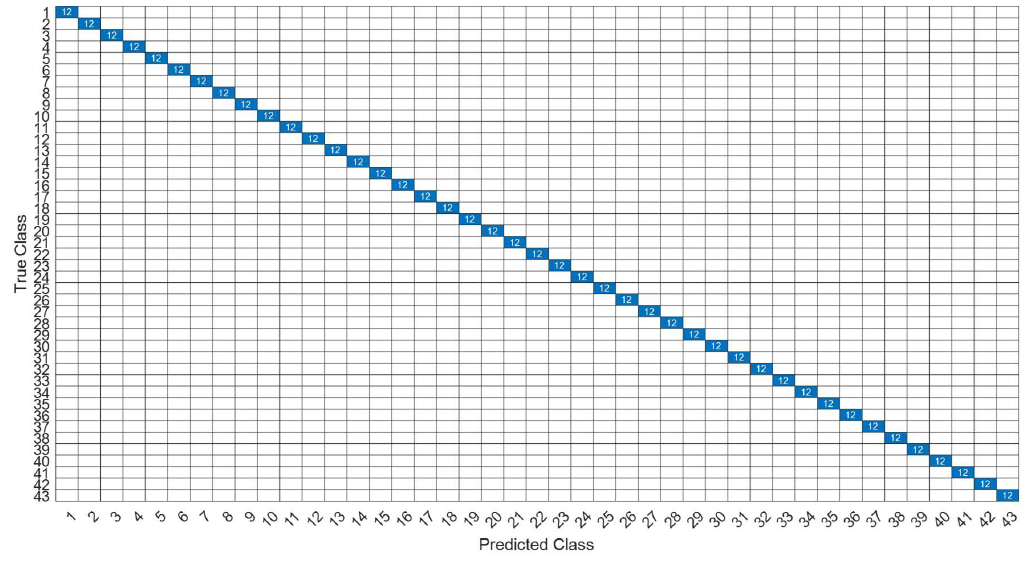
Figure 29. The confusion matrix of the CNN model with LPC 40-features dataset.